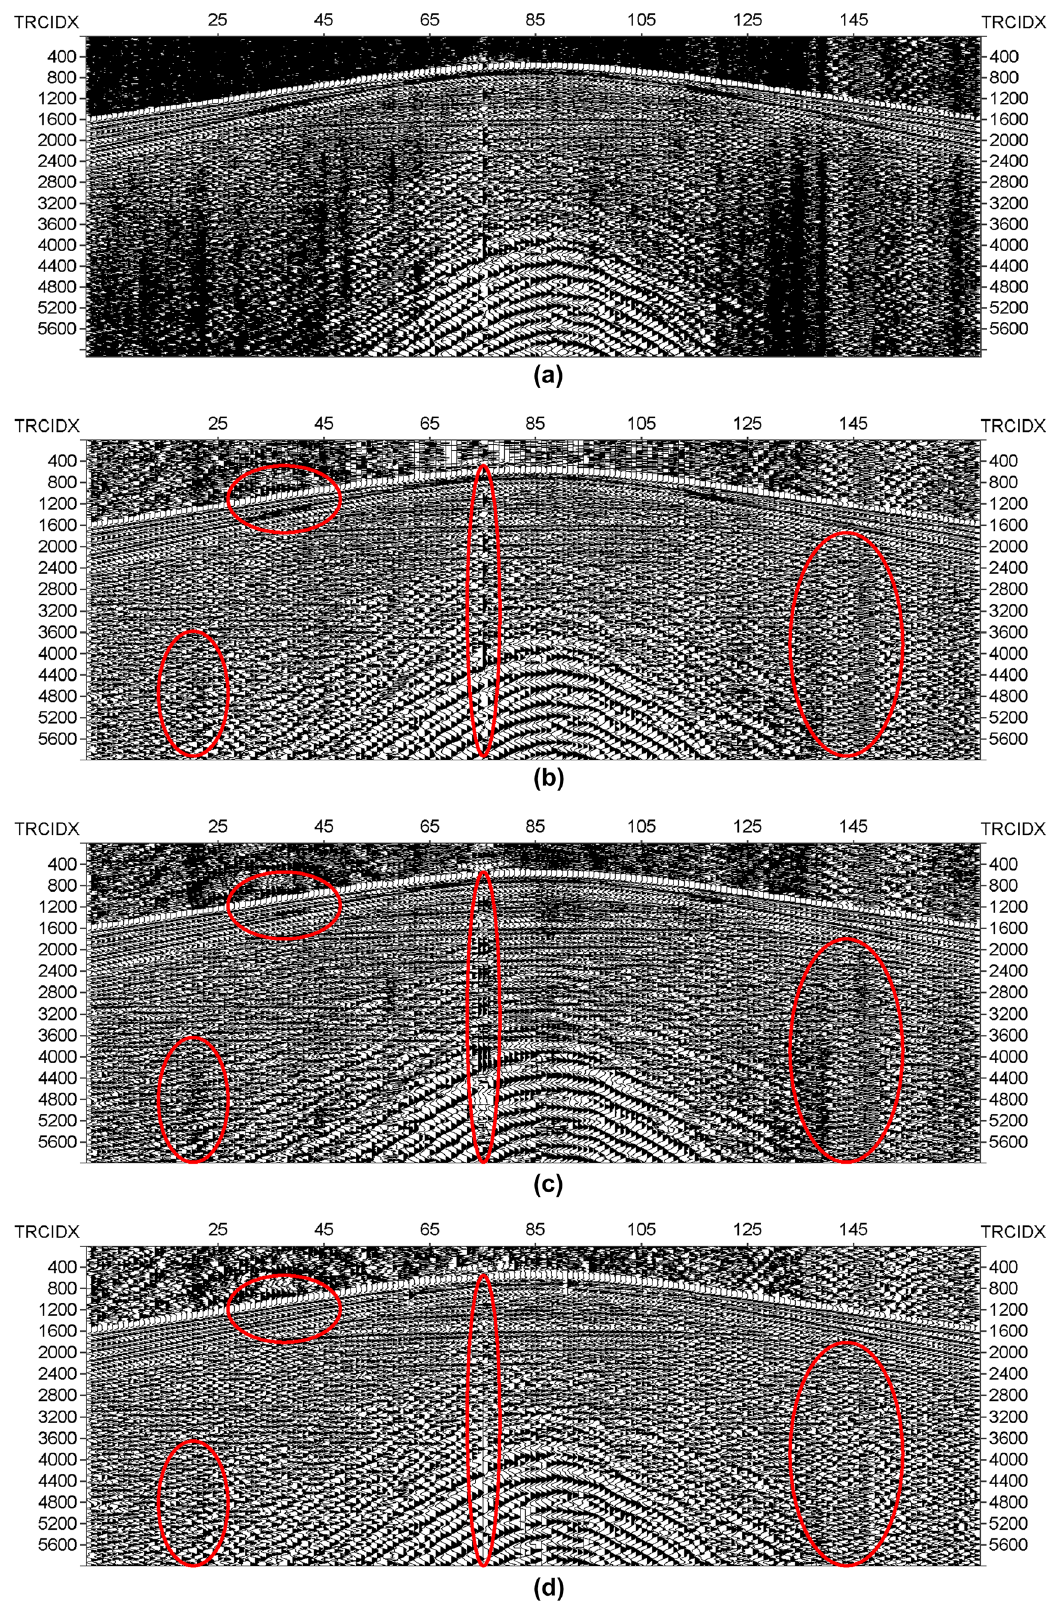
Fig. 14 a Field seismic record. b Result by the conventional TFPF. c Result by the PT-TFPF. d Result by the